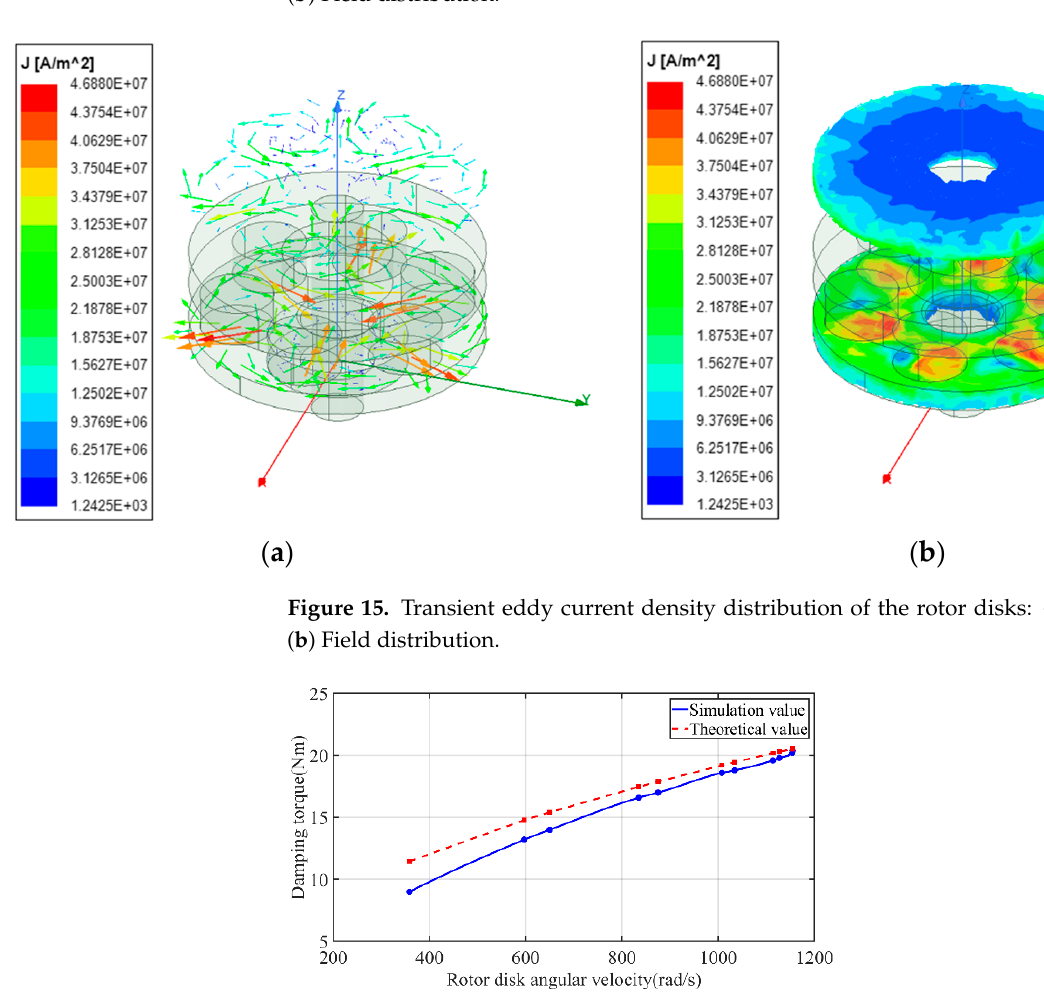
Figure 16. Distribution of damping torque with angular velocity of the rotor disks.